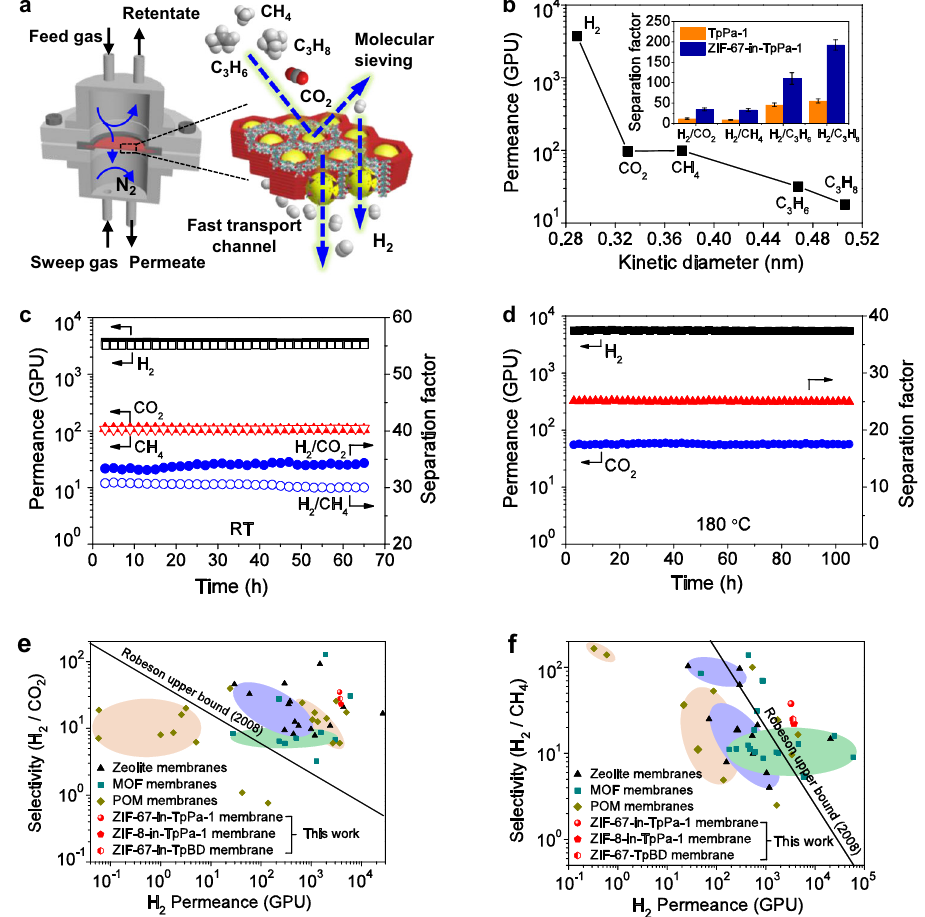
Fig. 3 Gas-permeation performance. a Home-made gas-permeation module and schematic illustrating gas transport through ZIF-67-in-TpPa-1 membrane. b Single-gas permeances of ZIF-67-in-TpPa-1 membrane as a function of kinetic diameter of permeating molecules at 298 K and 1 bar. The inset shows the mixed-gas-separation factor of ZIF-67-in-TpPa-1 membrane and TpPa-1 membrane for H 2 over other gases. Long-term tests of ZIF-67-in-TpPa-1 membrane for ( c ) equimolar gas mixture of H 2 /CO 2 and H 2 /CH 4 at 298 K and 1 bar, and ( d ) equimolar gas mixture of H 2 /CO 2 at 453 K (180 °C) and 1 bar. Mixed-gas selectivities of ( e ) H 2 /CO 2 and ( f ) H 2 /CH 4 , as a function of H 2 permeance for our MOF-in-COF membranes compared with literature data. Information on the data points is given in Supplementary Tables 2,